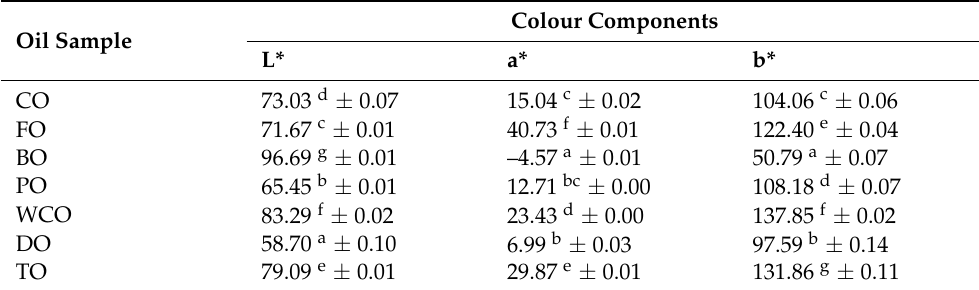
Table 2. Colour components in the CIE L*, a*, b* system of analysed